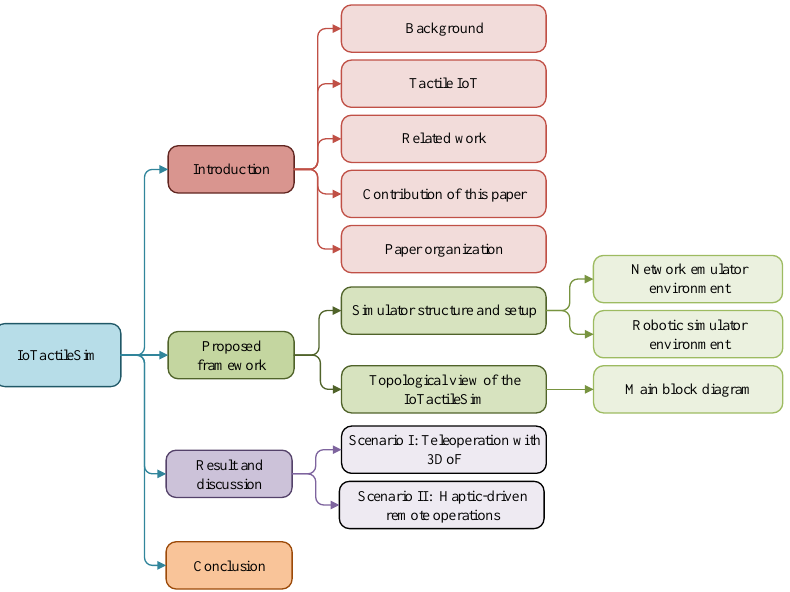
Figure 3. Diagrammatic view of the structure of the